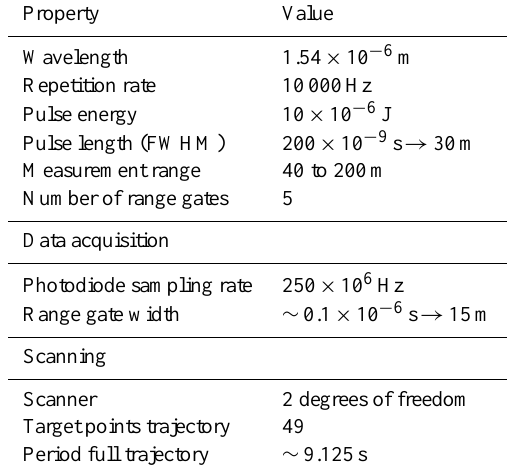
Table A1. Characteristics of lidar scanner of the University of Stuttgart. Windcube WLS-7 version 1, extended with a scanning